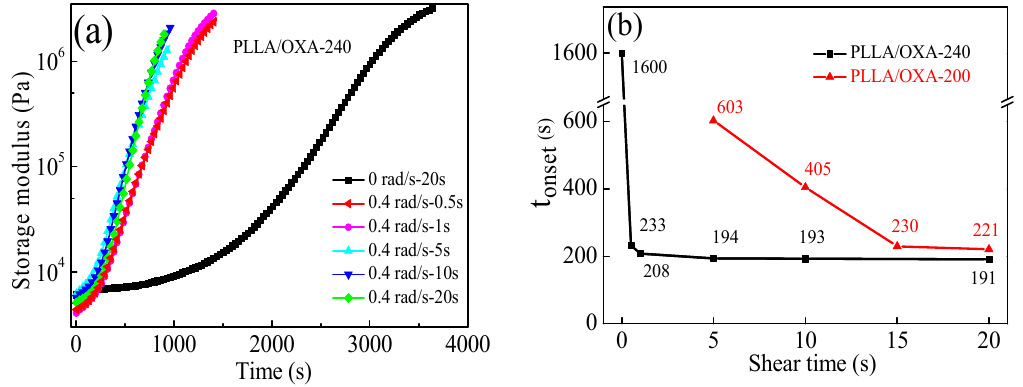
Figure 6. ( a ) Storage modulus of the PLLA/OXA-240 samples as a function of shear time and isothermal crystallization time at 155 °C and ( b ) the t onset values of the PLLA/OXA samples as a function of shear time. The shear rate is fixed at 0.4 rad/s for all samples and the PLLA/OXA-200 sample without shear did not crystallize within the experimental time span (90 min).